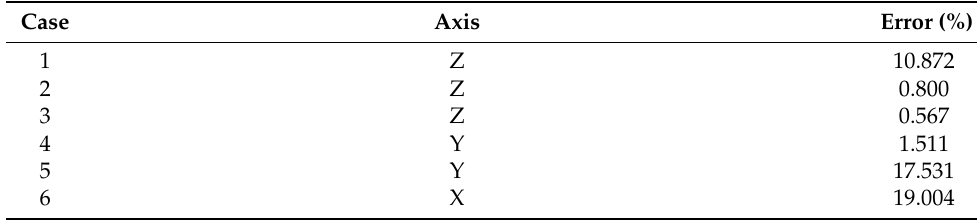
Table 4. Error for Timoshenko beams